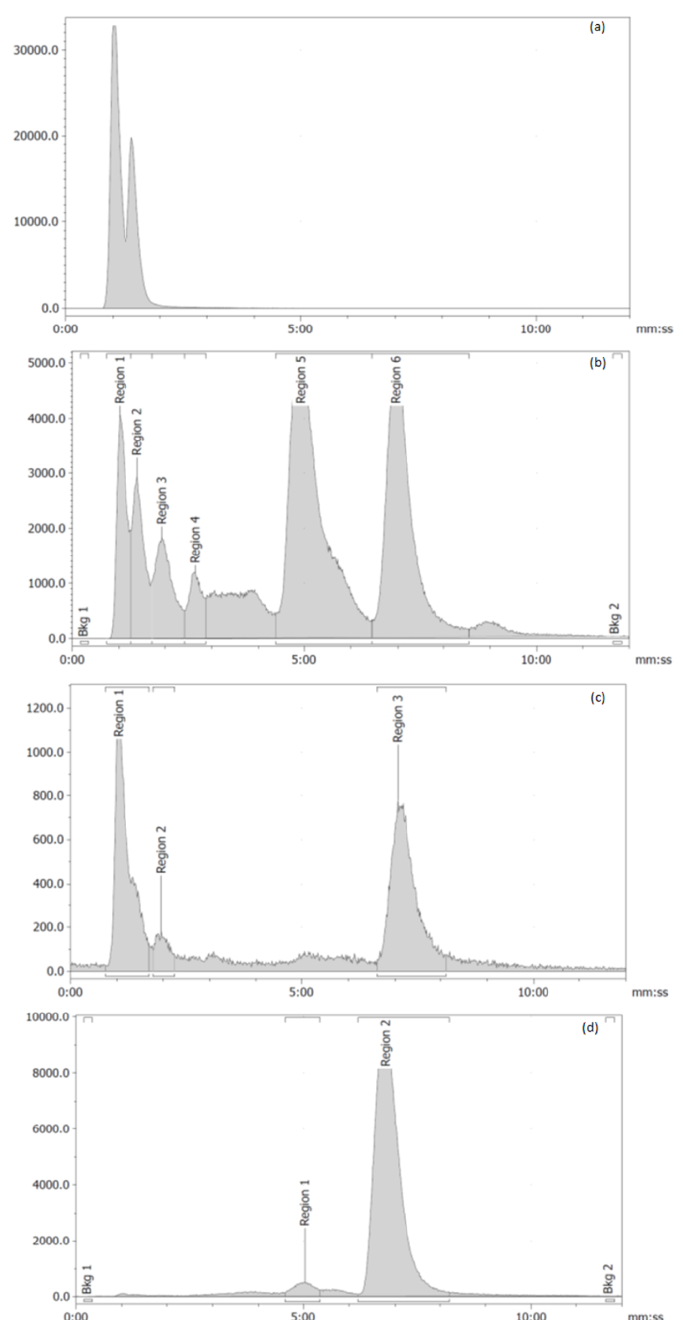
Figure 10. Radio-HPLC profiles of the fractions eluted out of ( a ) the MISPE. Loading and washing, ( b ) cleaning and ( c ) washing, reconditioning, ( d ) eluted product; ( a – c ) are considered “waste”. The radioactive peaks before 3 min are unreacted [ 11 C]CH 3 I and [ 11 C]CH 3 OH, the radioactive peak around 5 min is an unknown radioactive byproduct, and the radioactive peak around 7 min is the desired [ 11 C]RAC.